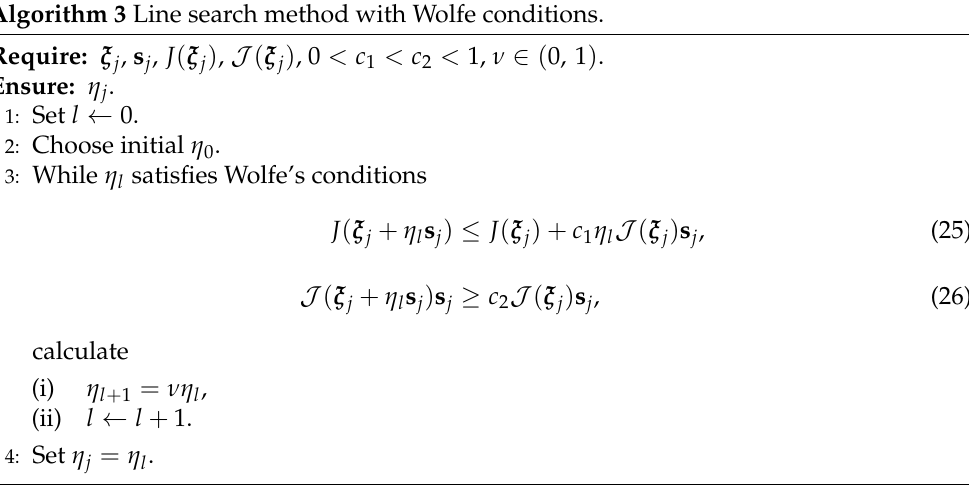
Algorithm 3 Line search method with Wolfe